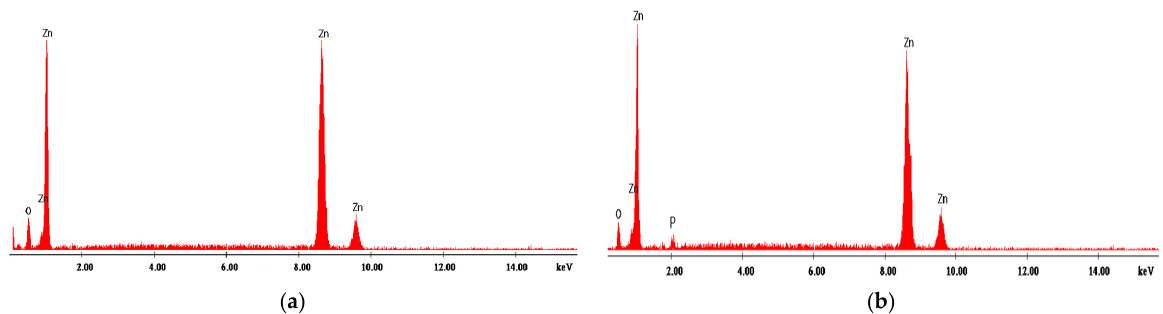
Figure 4. EDX analysis of zinc oxide ( a ) before and ( b ) after phosphorus adsorption.